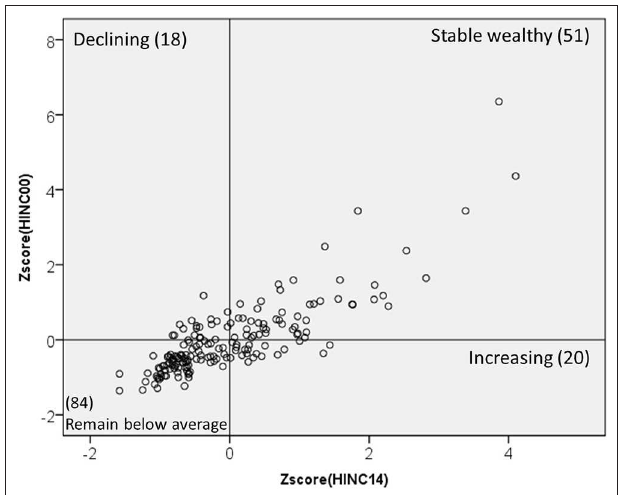
FIGURE 2 | Z scores on distribution of income between 2000 and 2014.